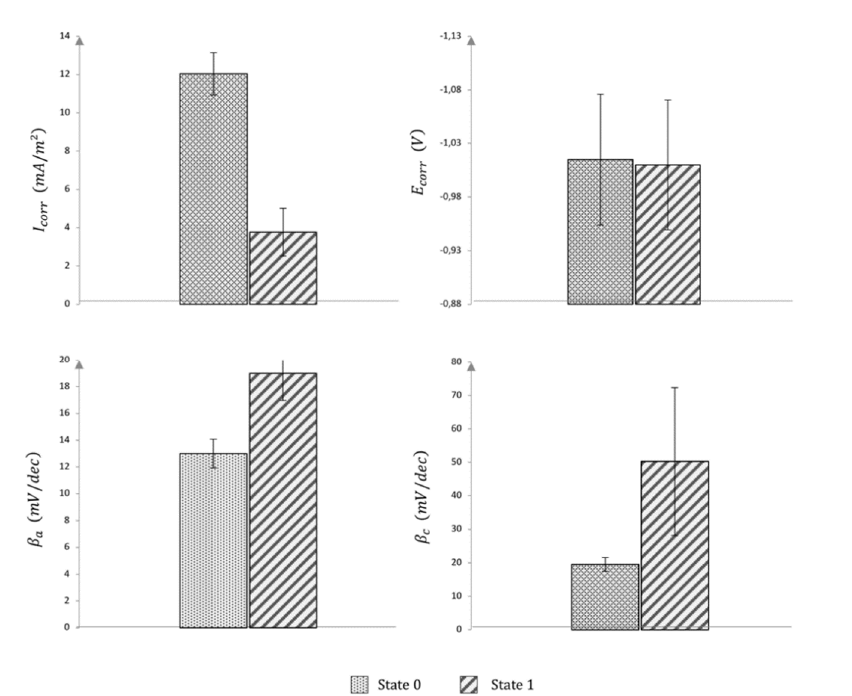
Figure 8. Bar chart with confidence intervals of the ZLA electrochemical properties identified for the 2 ageing